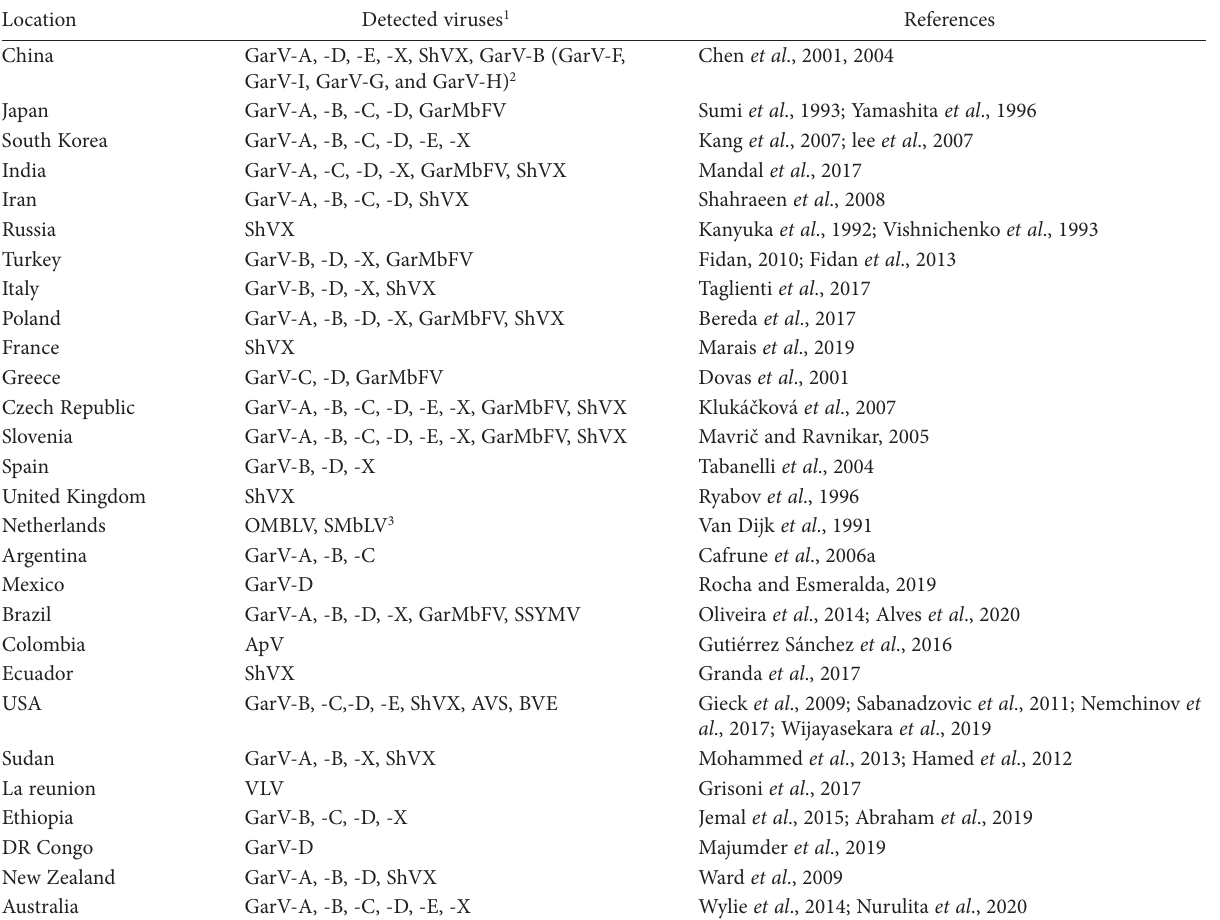
Table 2. Geographical distribution of